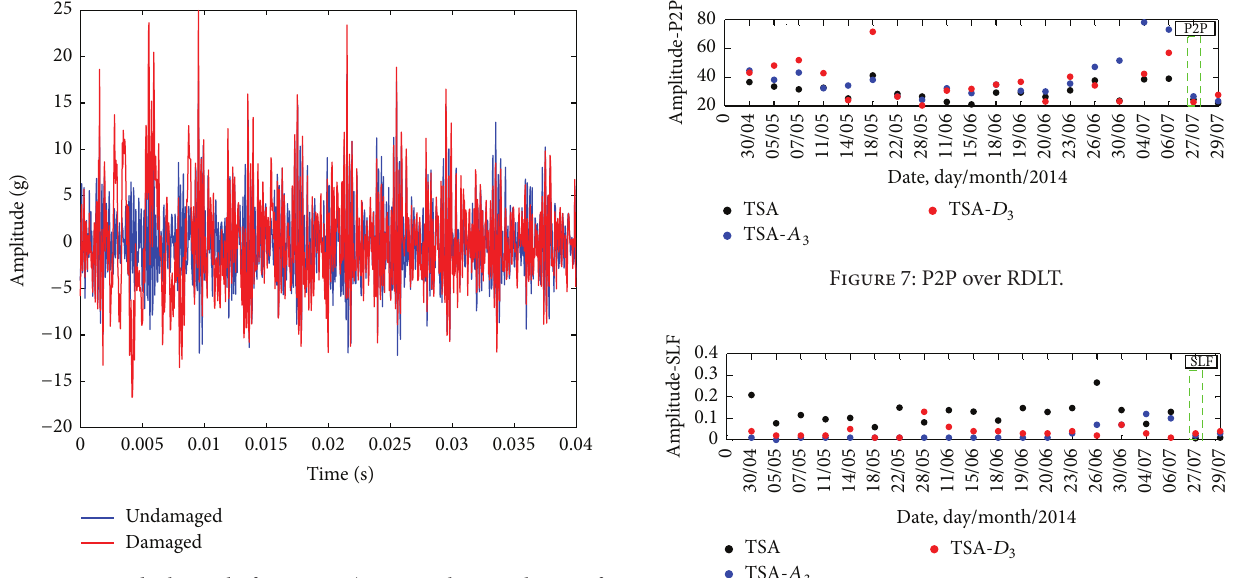
Figure 6: Residual signal of HSS gear (one complete revolution of HSS gear).